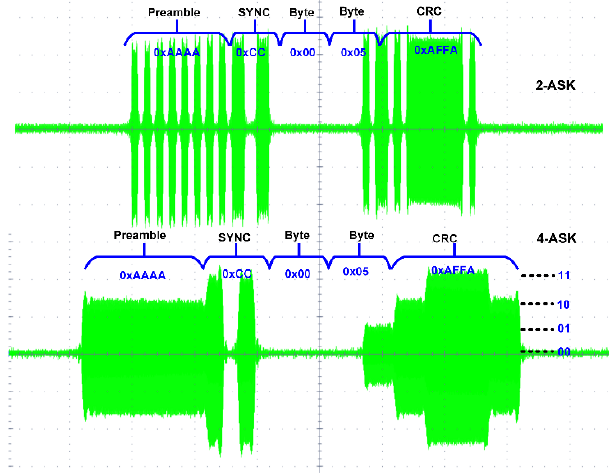
Figure 22. The RF 2-ASK and 4-ASK modulated SSF frame at 5.8 GHz.